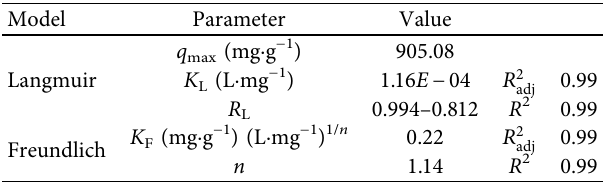
Figure 5: Cu(II) adsorption by SSP: (a) isotherm fitting of Langmuir and Freundlich; (b) plot of ln K Table 3: Isotherms parameters of Cu(II) adsorption by SSP. Model Parameter